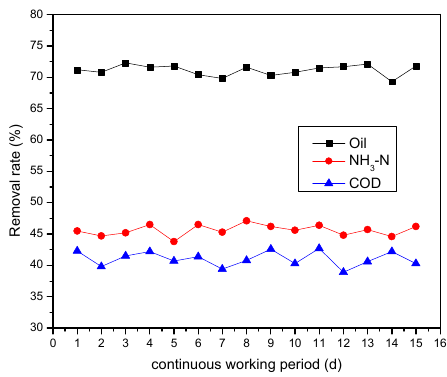
Figure 9. Removal efficiency of pollutants for continuous running.